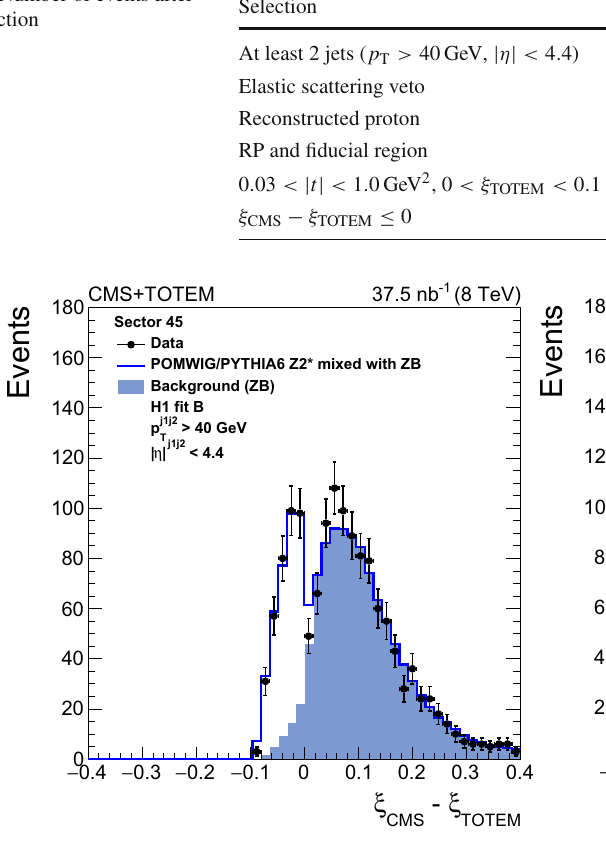
proton measured in the RPs contributes to the open histogram (signal) if the proton originates from the MC sample, or to the filled